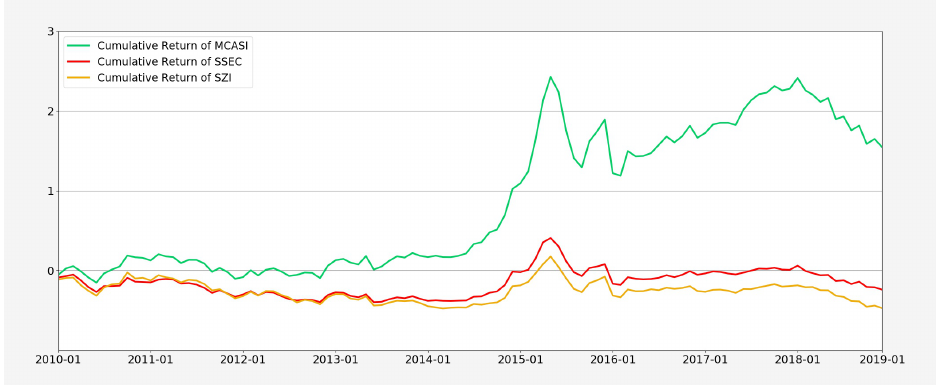
Figure 2. Cumulative Return of MCASI. Notes: Figure 2 presents cumulative returns of MCASI, SSEC and SZI in our sample period. SSEC and SZI stand for Shanghai Composite Index and Shenzhen Component Index, respectively. The sample period extends from January 2010 to December